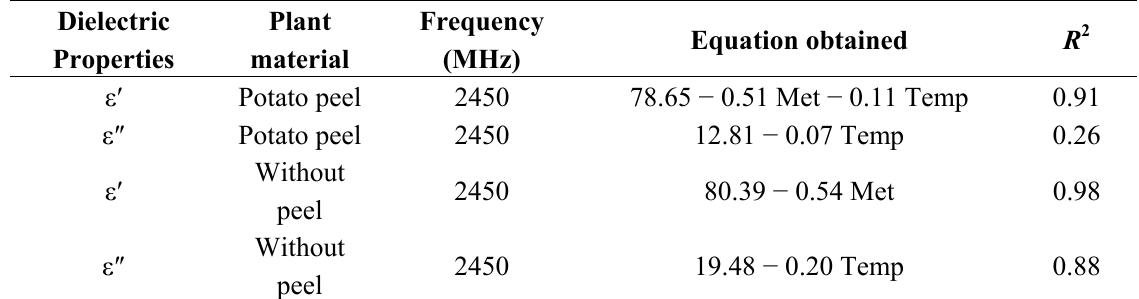
Table 1. Equations defining the relationship between ε′ and ε″ with temperature and methanol fraction concentration at 2450 MHz (Source: Adapted from